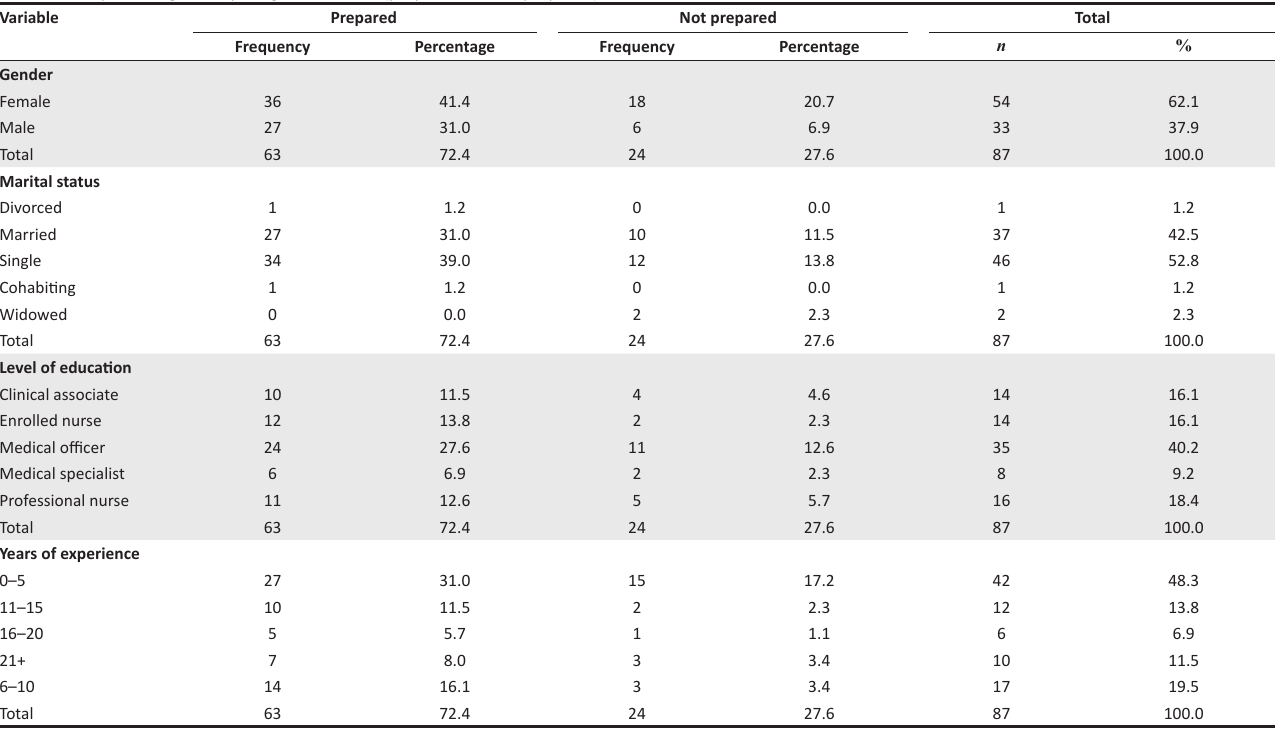
Table 3: Row percentages comparing the bivariate (prepared vs. non-prepared) variables.